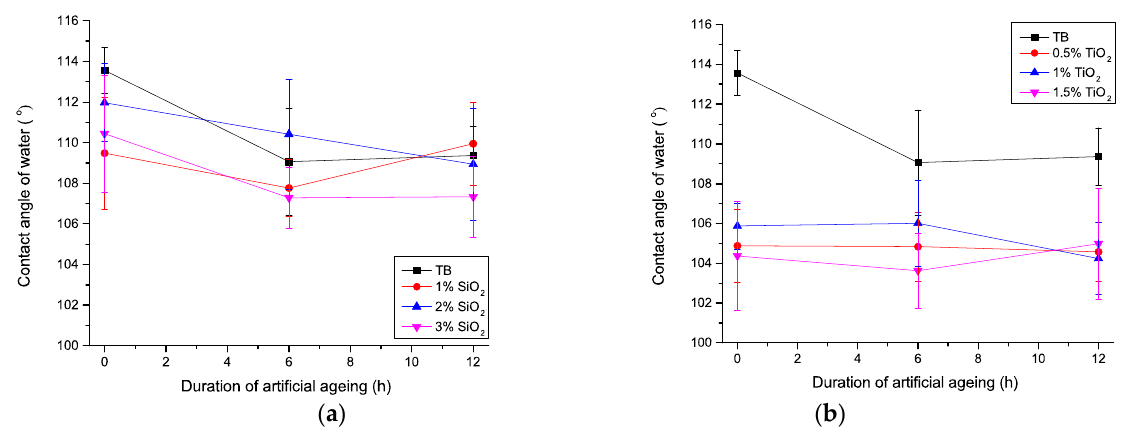
Figure 9. Contact angles of water on the unaged and aged FC with addition of ( a ) SiO 2 ; ( b ) TiO 2 nanoparticles.